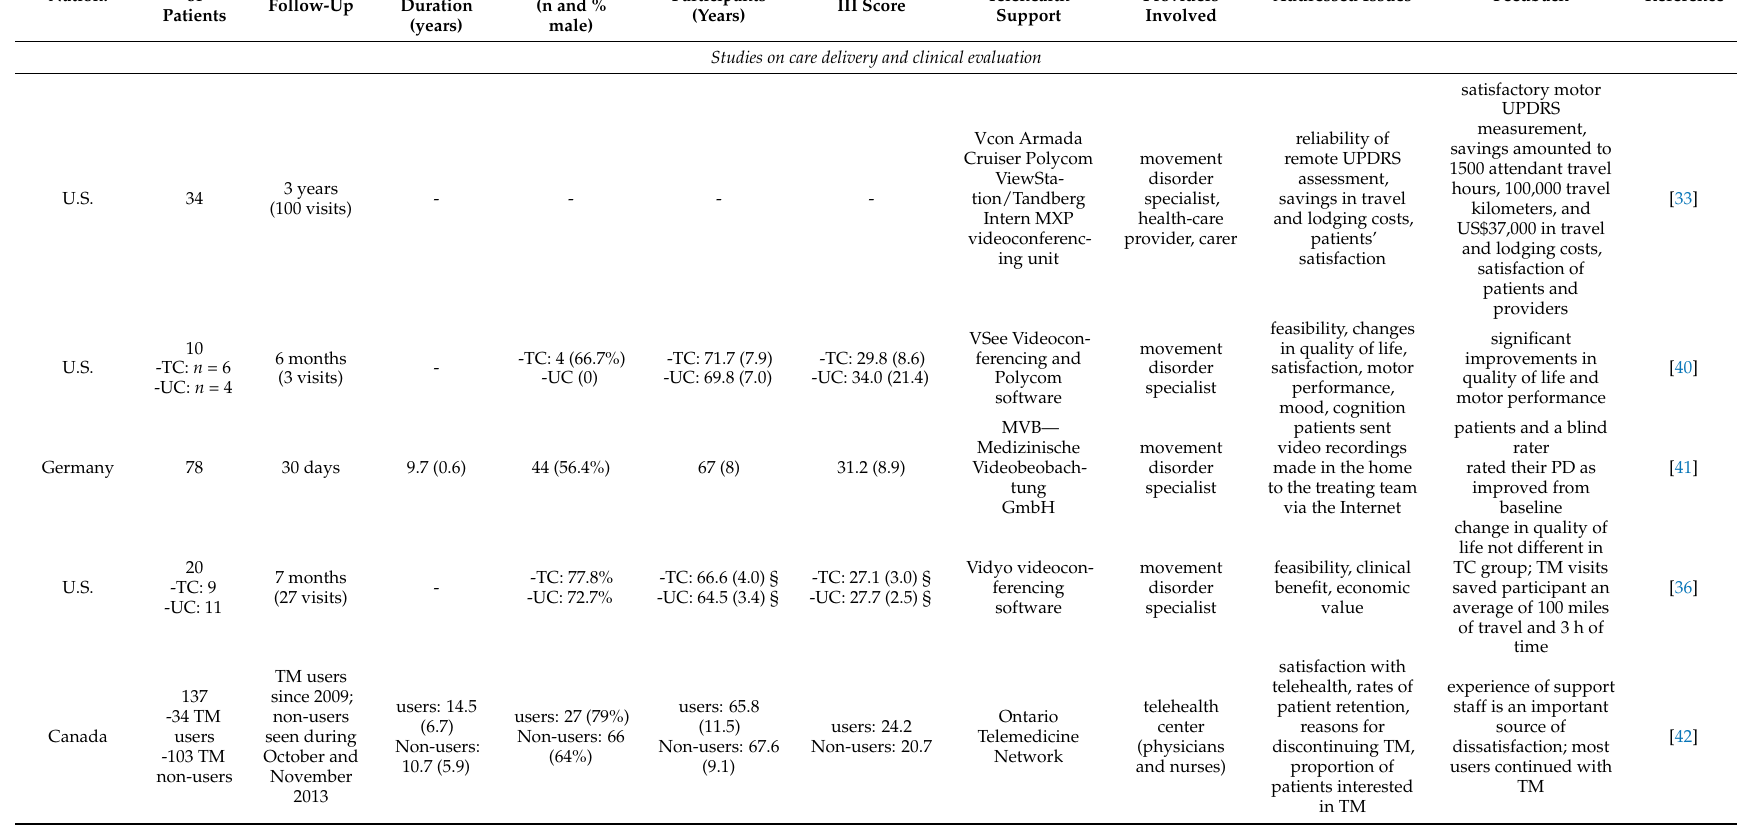
Table 3. Case series, observational studies and randomized controlled trials on telemedicine in Parkinson’s Disease. Continuous variables are expressed as mean (SD) unless otherwise specified. § Mean (SE). Abbreviations: HBMM: home-based motor monitoring; ISIBT: in-clinic sensory integration balance training; LSVT: Lee Silverman Voice Treatment; OBM: office-based management; SRE: self-regulated exercise; TAE: telecoach-assisted exercise; TAU: treatment as usual; TC: telemedicine care; TM: telemedicine; T-CBT: telephone-based cognitive-behavioral treatment; UC: usual care; VHC: virtual house calls; VRT: virtual reality telerehabilitation. Reference period: until the end of 2019 (excluded studies involving the COVID-19 period, cited in the Section 2.2).